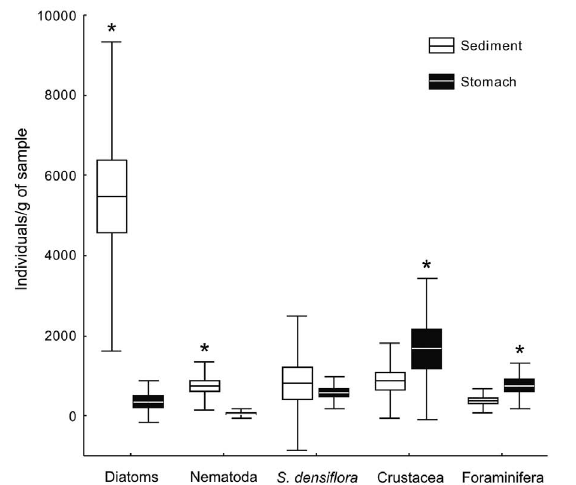
Fig. 2. – Neohelice granulata . Number of organisms or their remains present in sediment used as food and in stomachs after deposit feed- ing. Horizontal line in box, mean; box, mean±standard error; whisk- ers, mean±standard deviation. Asterisks indicate significant greater values (paired t-test, p<0.05).